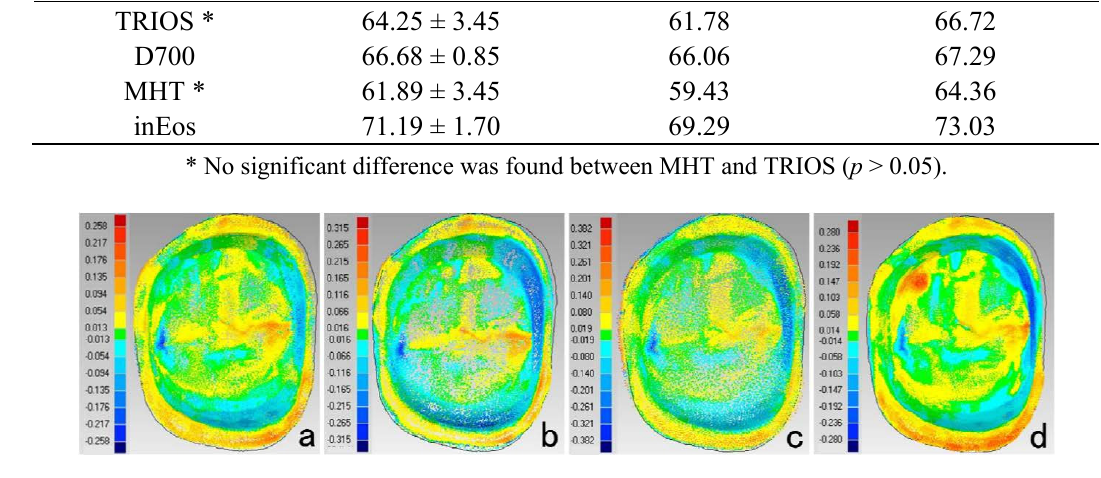
Figure 2. Color-coded difference images showed the deviations between REF and each scanner. ( a ) TRIOS ( b ) D700 ( c ) MHT ( d ) inEos (Buccal surface is on the top; mesial surface is on the